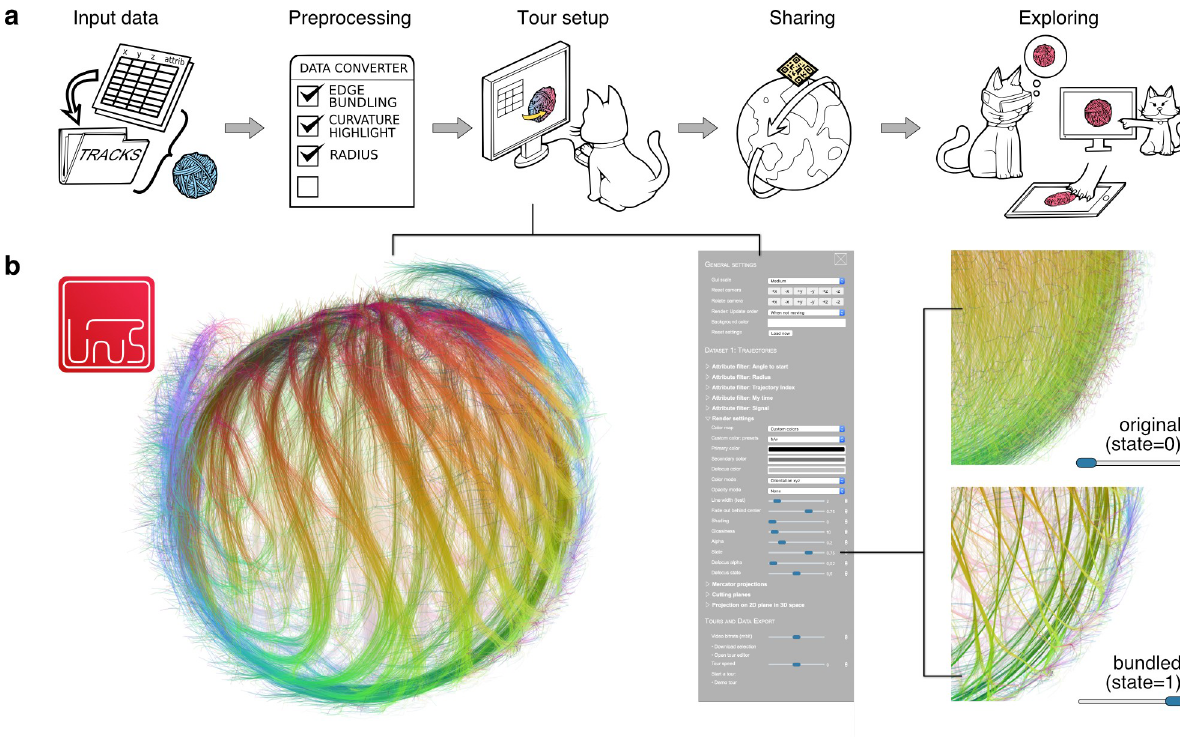
Fig 1. Browser-based exploration and sharing of trajectory visualisations with linus . (a) Control workflow of linus . (Input data) linus can import tracking data from a variety of formats. (Preprocessing) The Python-converter additionally enriches the imported data with additional features (providing e.g. an edge-bundled version of the data, visual context, or a coordinate system) and prepares the visualisation packet. (Tour setup) The user can open the visualisation in a web browser and create an interactive presentation of the data. (Sharing) These visualisations can be shared via a URL, or a QR code and (Exploring) readily presented and explored across various devices. (b) Overview of the graphical user interface (GUI). The data can be visualised and explored in the browser. Different aspects of the data can be interactively highlighted (zoomed example on the right shows the effect of changing the degree of trajectory